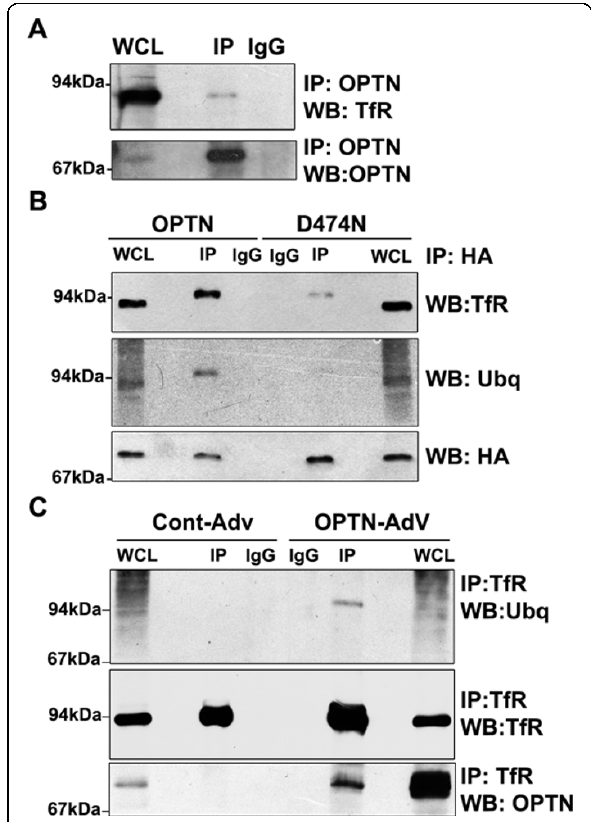
Figure 9 Optineurin interacts with TfR through UBD . (A) Endogenous optineurin interacts with endogenous TfR. Endogenous optineurin was immunoprecipitated from HeLa cells using anti- optineurin or control antibody. Immunoprecipitates were resolved in SDS-PAGE and subjected to Western blotting with TfR and optineurin antibodies. (B) UBD of optineurin is essential for interaction with TfR. HeLa cells were transfected with HA-optineurin or HA-D474N mutant optineurin. After 30 hrs of transfection, lysates were immunoprecipitated with anti-HA or control antibody and subjected to Western blotting with TfR, ubiquitin and HA antibodies. (C) TfR was immunoprecipitated from optineurin-overexpressing and control cells. Western blot of the immunoprecipitate was done with ubiquitin, TfR and optineurin antibodies. WCL, 5% whole cell